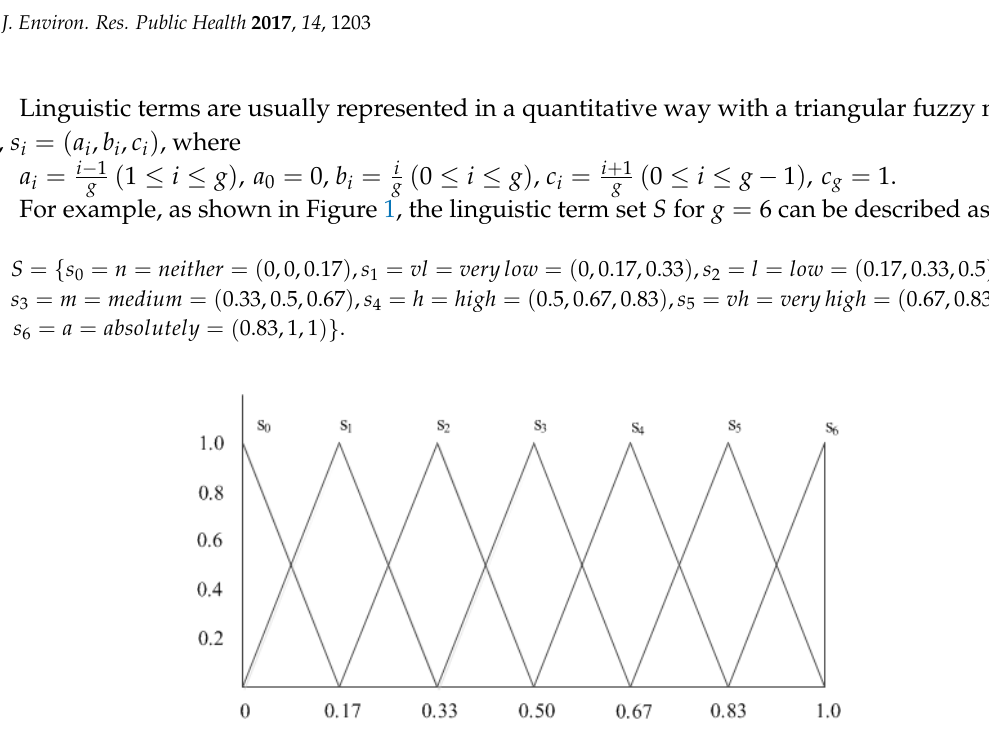
Figure 1. Set of seven terms with its triangular fuzzy number representation.